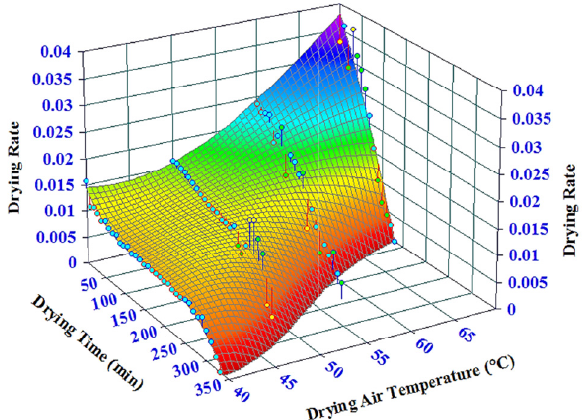
Fig. 15. Drying rate versus drying time of hawthorn at different drying air temperatures (drying air flow rate=26 m 3 /h and vibration intensity=7.5